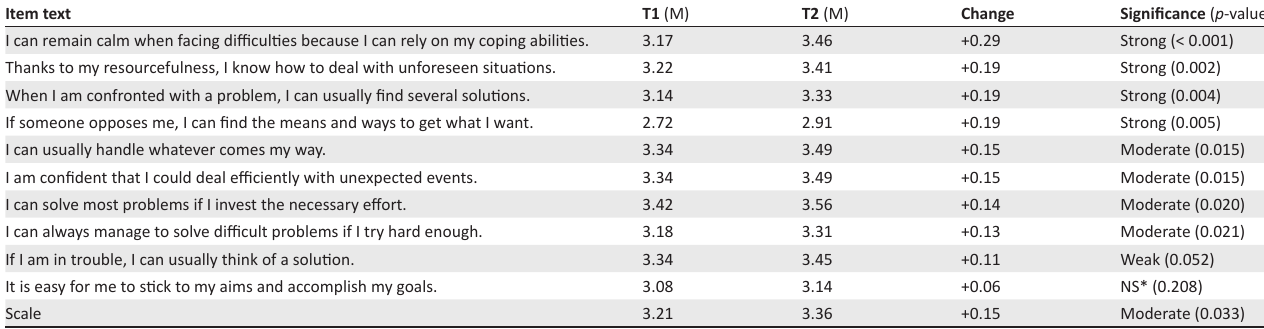
TABLE 6: Results for the General Self-Efficacy Scale: Item-level statistics. Item text